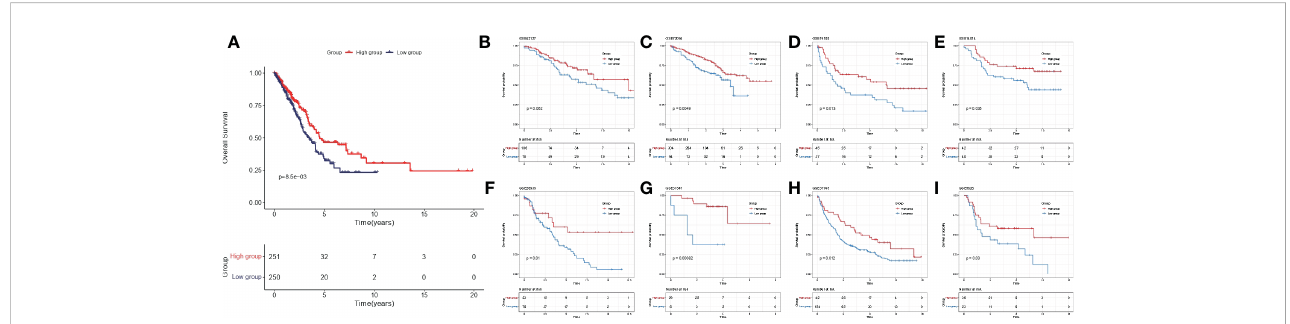
FIGURE 3 Validation of prognostic ef fi cacy of IL-1 in the lung cancer dataset. (A) K-M curves of the TCGA-LUAD cohort based on IL-1score (B-I) K-M curves of the eight independent validation datasets based on